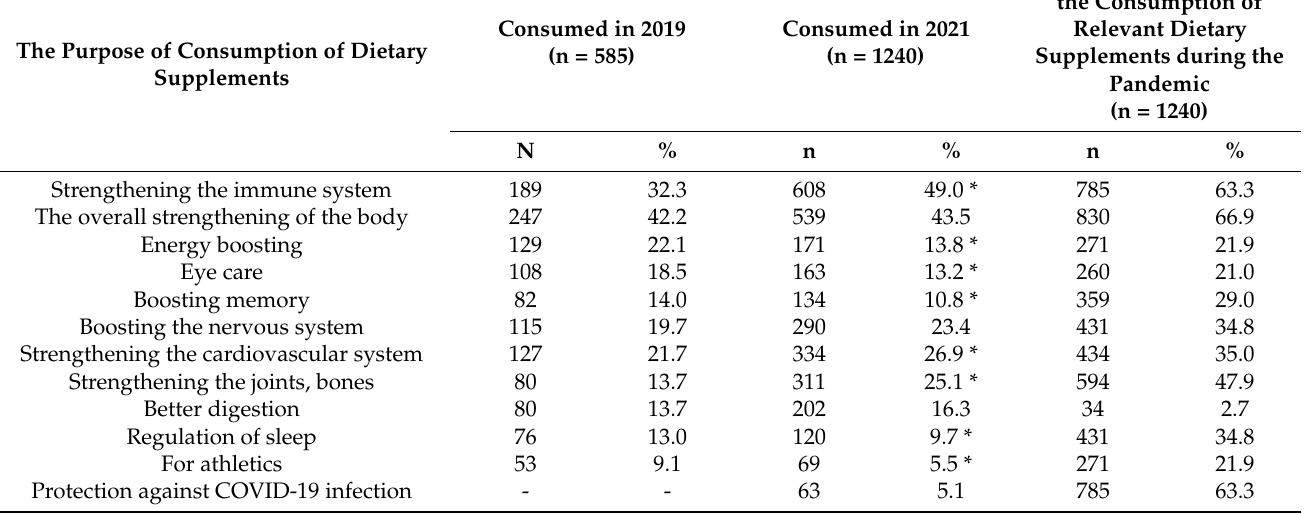
Table 6. Distribution of the respondents who consumed dietary supplements by the purpose of the consumption of dietary supplements and the consumption within past 12 months (in 2019 and 2021) and an increase in the consumption during the